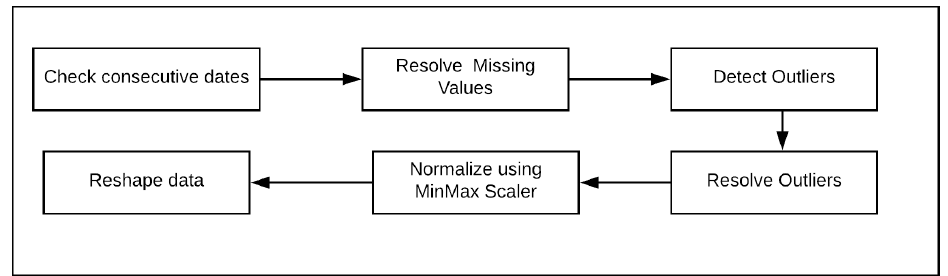
Figure 4. Data preprocessing. The data are preprocessed in 6 stages with the arrowheads showing the flow of